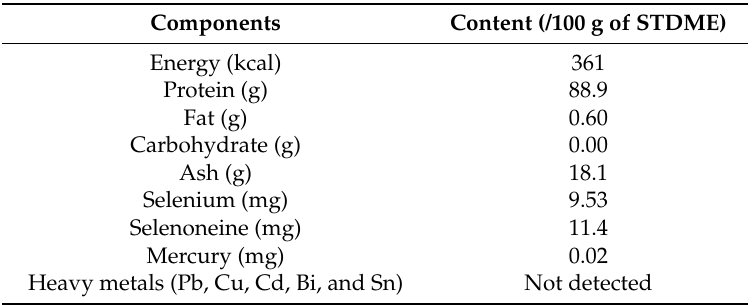
Table 1. Approximate composition and energy content of STDME.